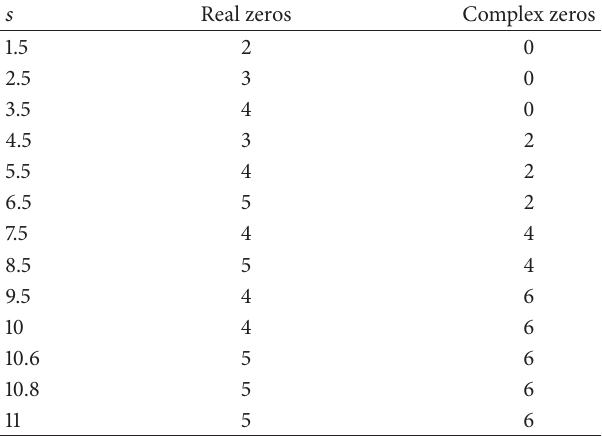
Table 1: Numbers of real and complex zeros of 𝐸 𝑞 (𝑠,𝑤) .